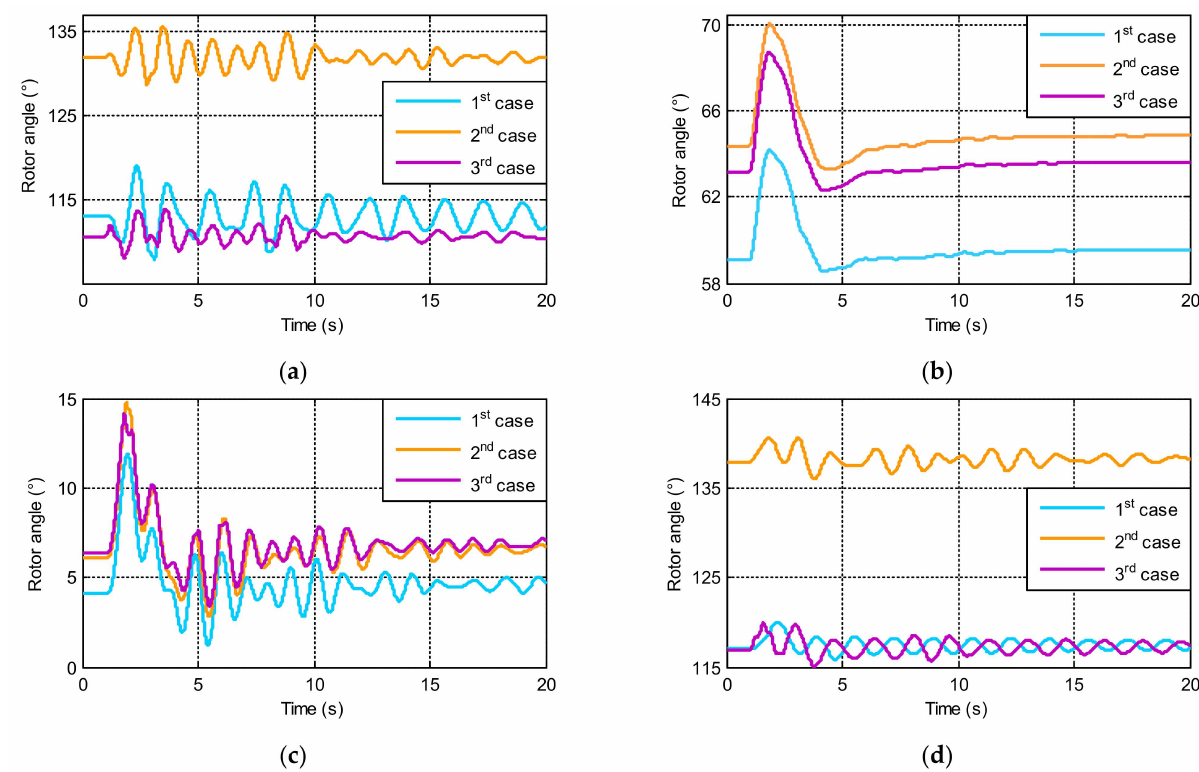
Figure 7. Transient response of the Iraqi super grid against a line disturbance for different cases: ( a ) spread angle; ( b ) average angle; ( c ) smallest angle; ( d ) largest